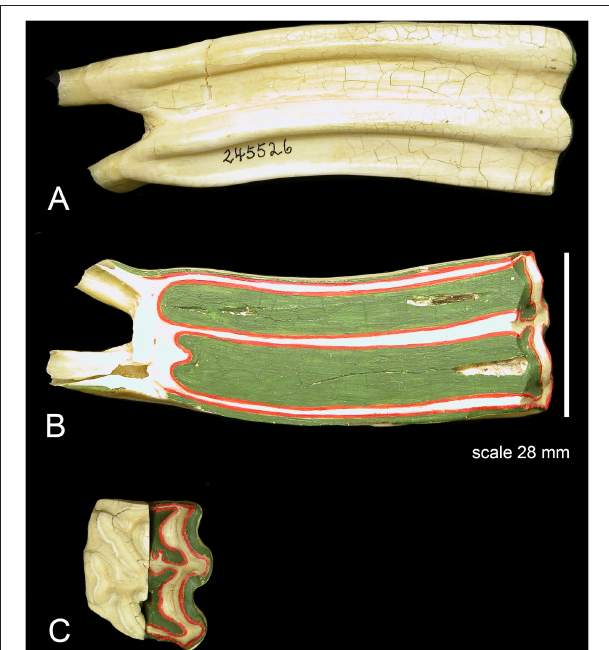
FIGURE 3 | (A) A class I lever representation of a hypsodont tooth. The black bar is the exposed functioning enamel crown. The black arrow is the transverse force not a vertical force. The green shows the fulcrum point as the opening of the alveolar space (again transverse) and the red line is the plioroot deep into the maxilla. In developing this model, the tooth is tilted horizontally. F m is the force of mastication (estimated). L m is the length of the exposed tooth to mastication (measured) in the oral cavity. L a is the length of the crown embedded in the alveolus (measured). F a is the force of the alveolar tooth needed to stabilize the tooth during mastication (calculated). The fulcrum represents the interface between the exposed tooth and alveolar tooth and is the oral opening of the alveolus. Blue indicates the exposed tooth and red indicates the hidden alveolar portion of the tooth. (B) Applying Equation 3 with constant values L m = 14, F m = 500 lbsF m = 500 lbs , and knowing that the alveolar length of the tooth ( L α ) for a horse at age three is 70mm and age 18 is 2mm, we can plot the alveolar force F α vs. the alveolar length L α , shown in Figure 2